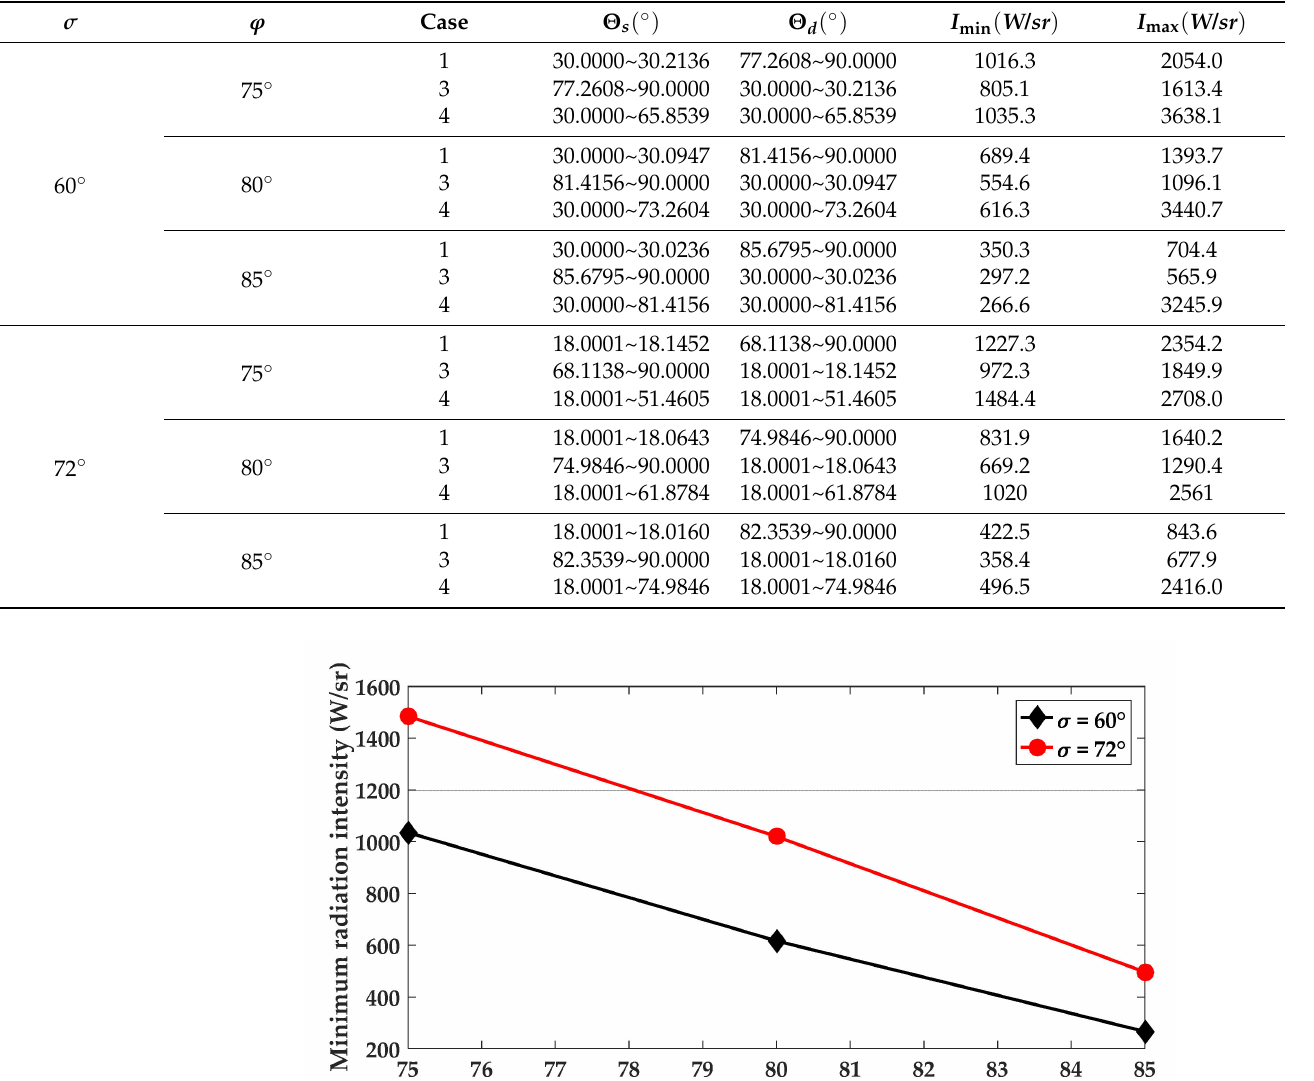
Table 1. The extreme values of radiation intensity of space targets received by detectors under different conditions.